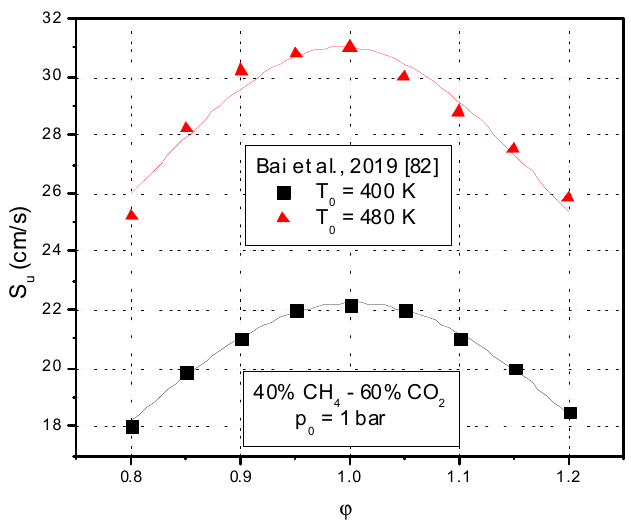
Figure 11. Initial temperature influence on experimental laminar burning velocity, at various equivalence ratios and 1 bar initial pressure.